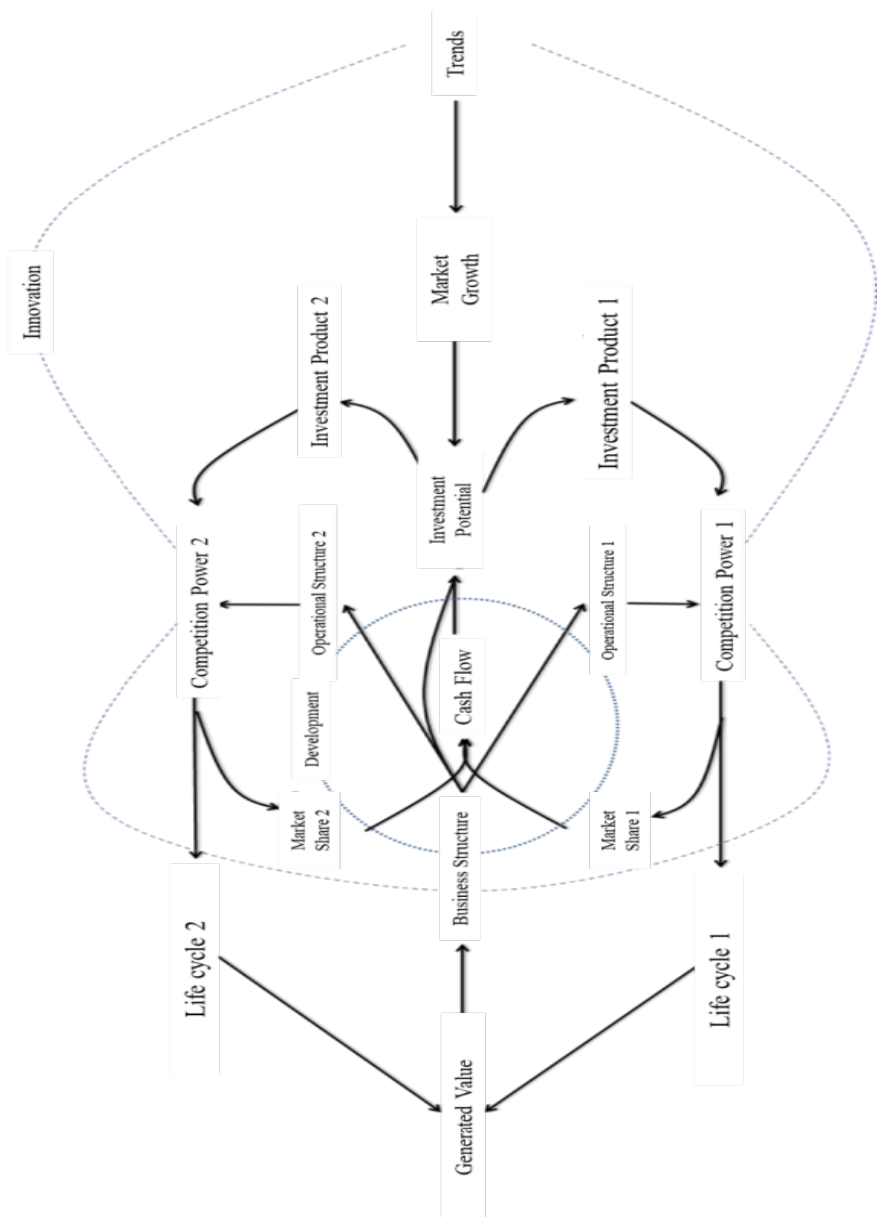
Figure 3. Systemic PPM